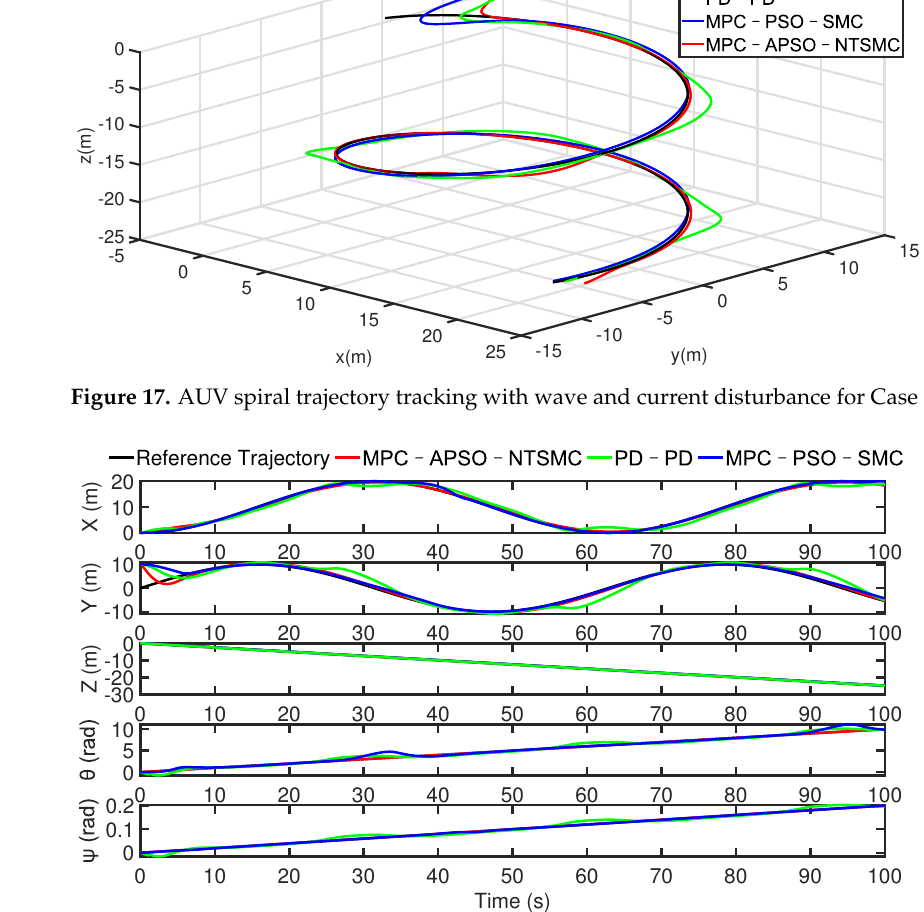
Figure 18. Position tracking performancesfor the tracking task with wave and current disturbance for Case 1.